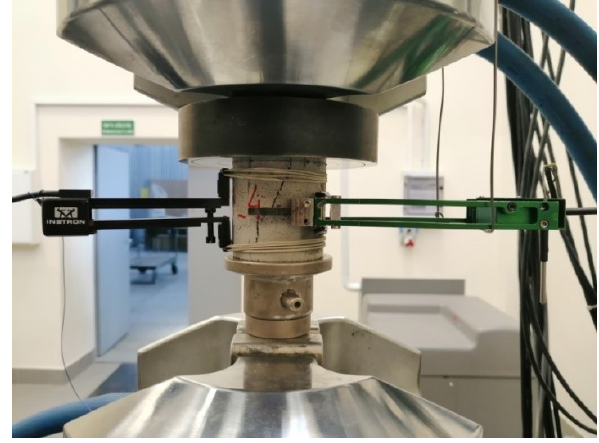
Figure 5: One of the samples of adhesive mortar with the